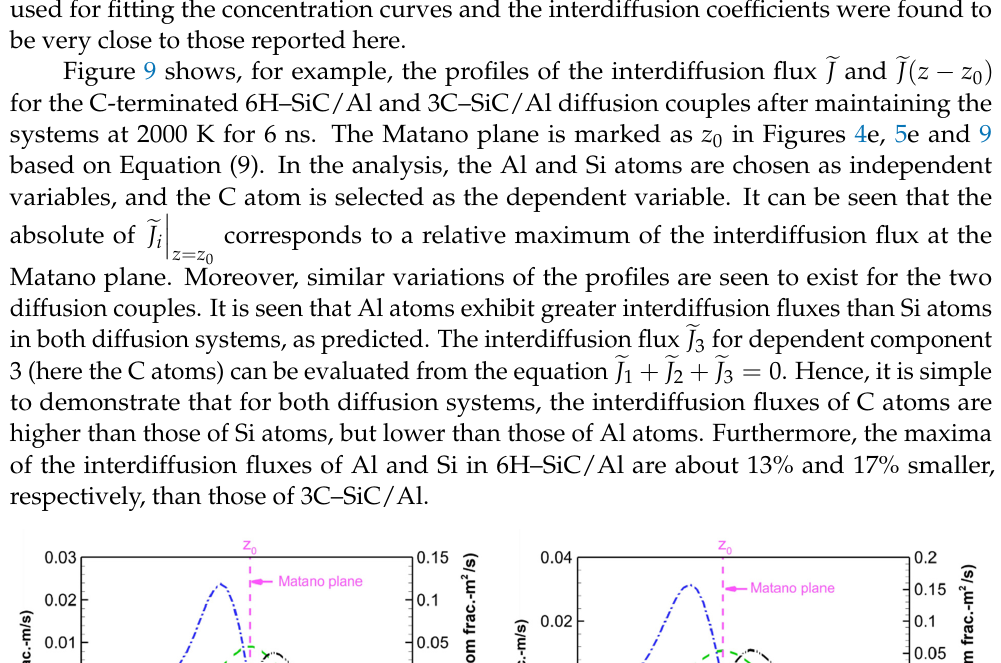
Table 3. Average values of ternary main and cross-interdiffusion coefficients on each side of the Matano plane after maintaining the system at the pre-set temperature for 6 ns (indices: 1 = Al; 2 = Si; 3 = C).